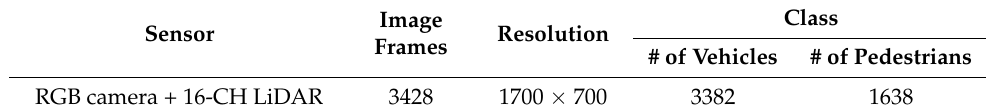
Table 2. Details of SCHF dataset.